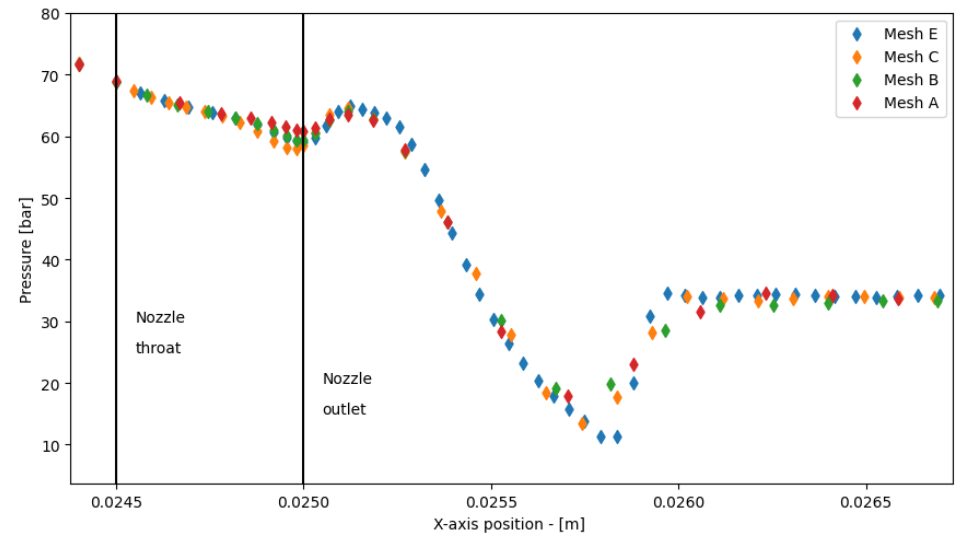
Figure 6. Pressure distribution for case I along the x-axis for meshes A, B, C, and E.